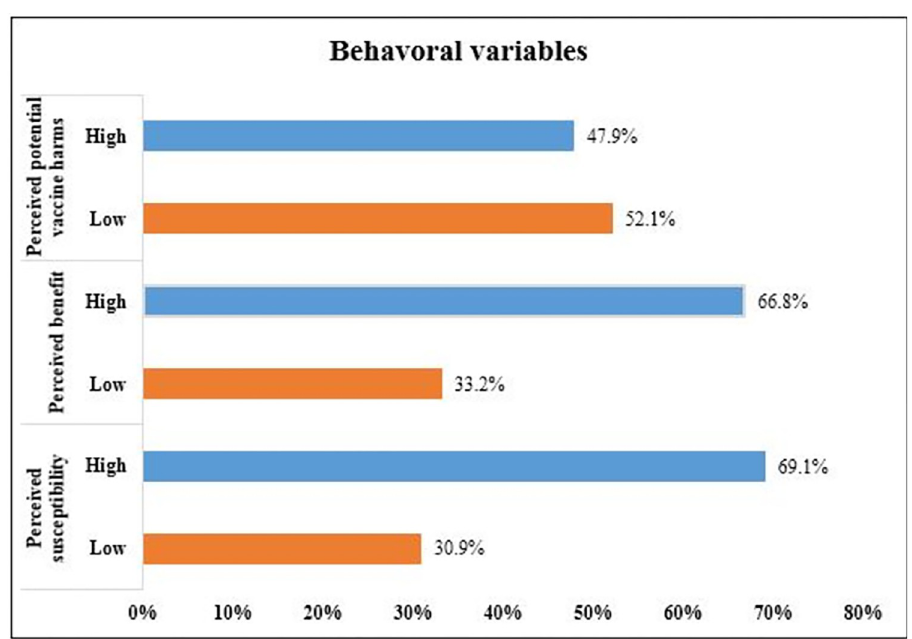
Fig 2. Respondent’s behavioral characteristics toward COVID-19 vaccine.